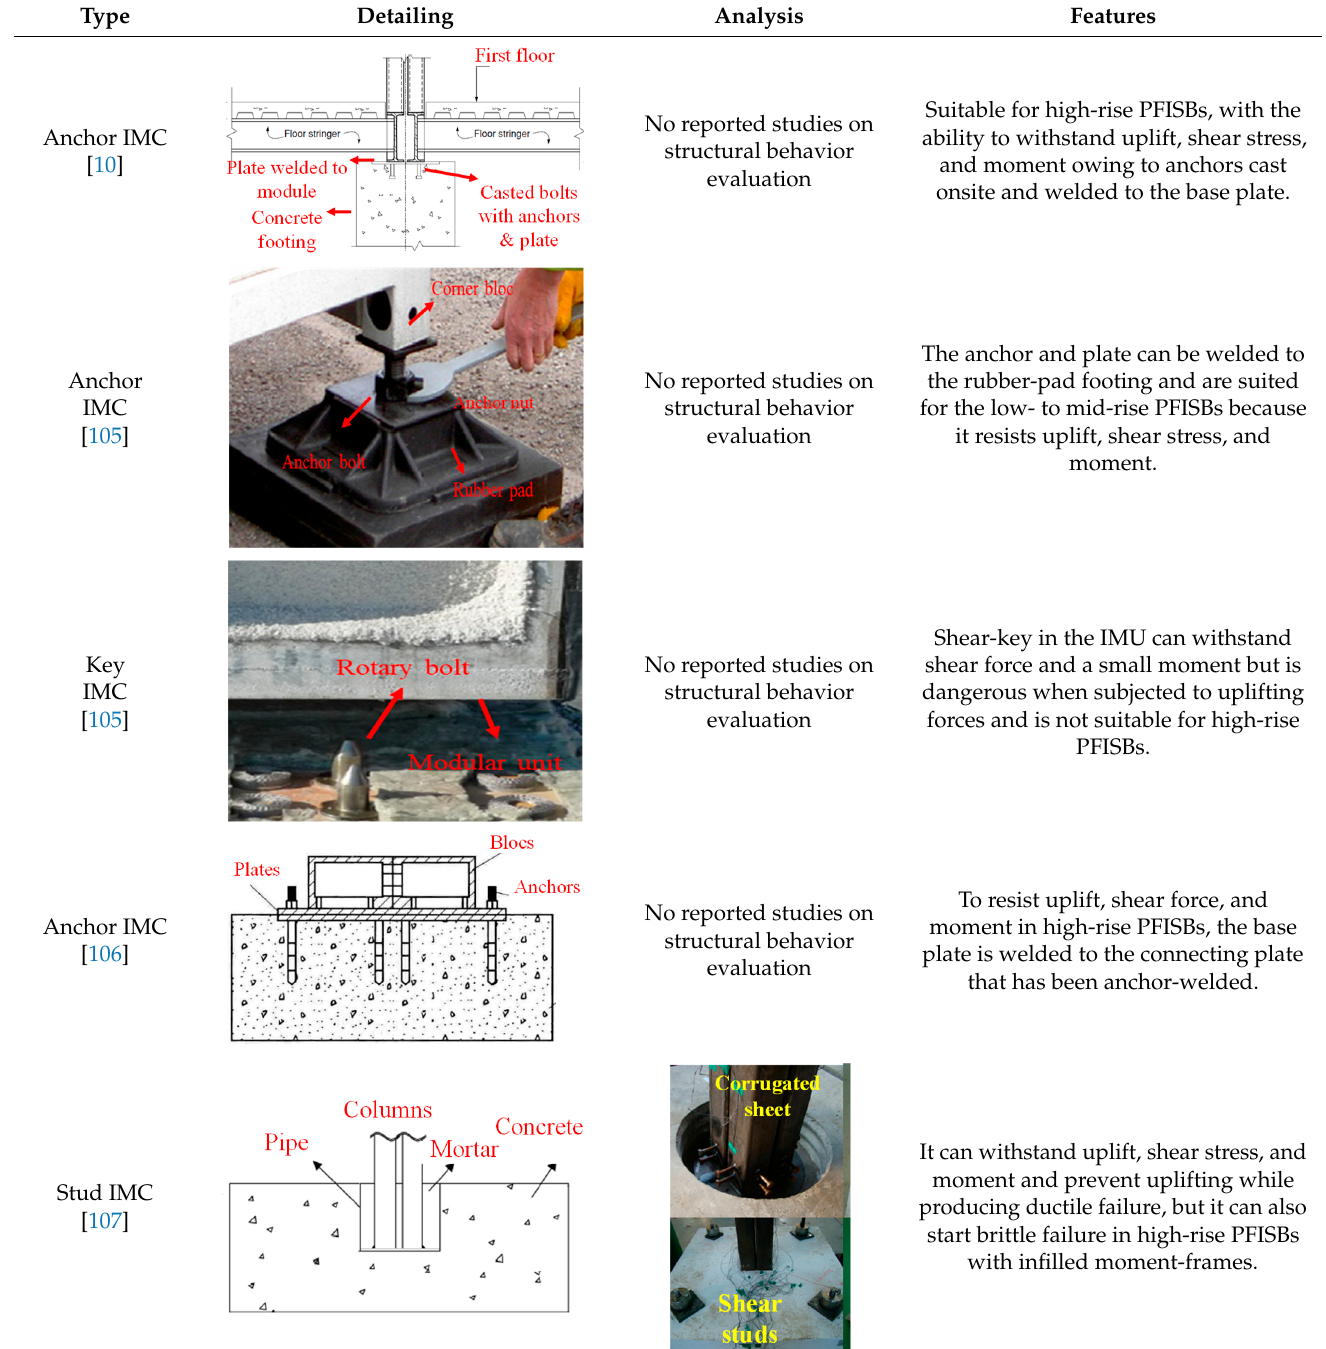
Table 1. Foundation IMCs and relevant PFISB studies.